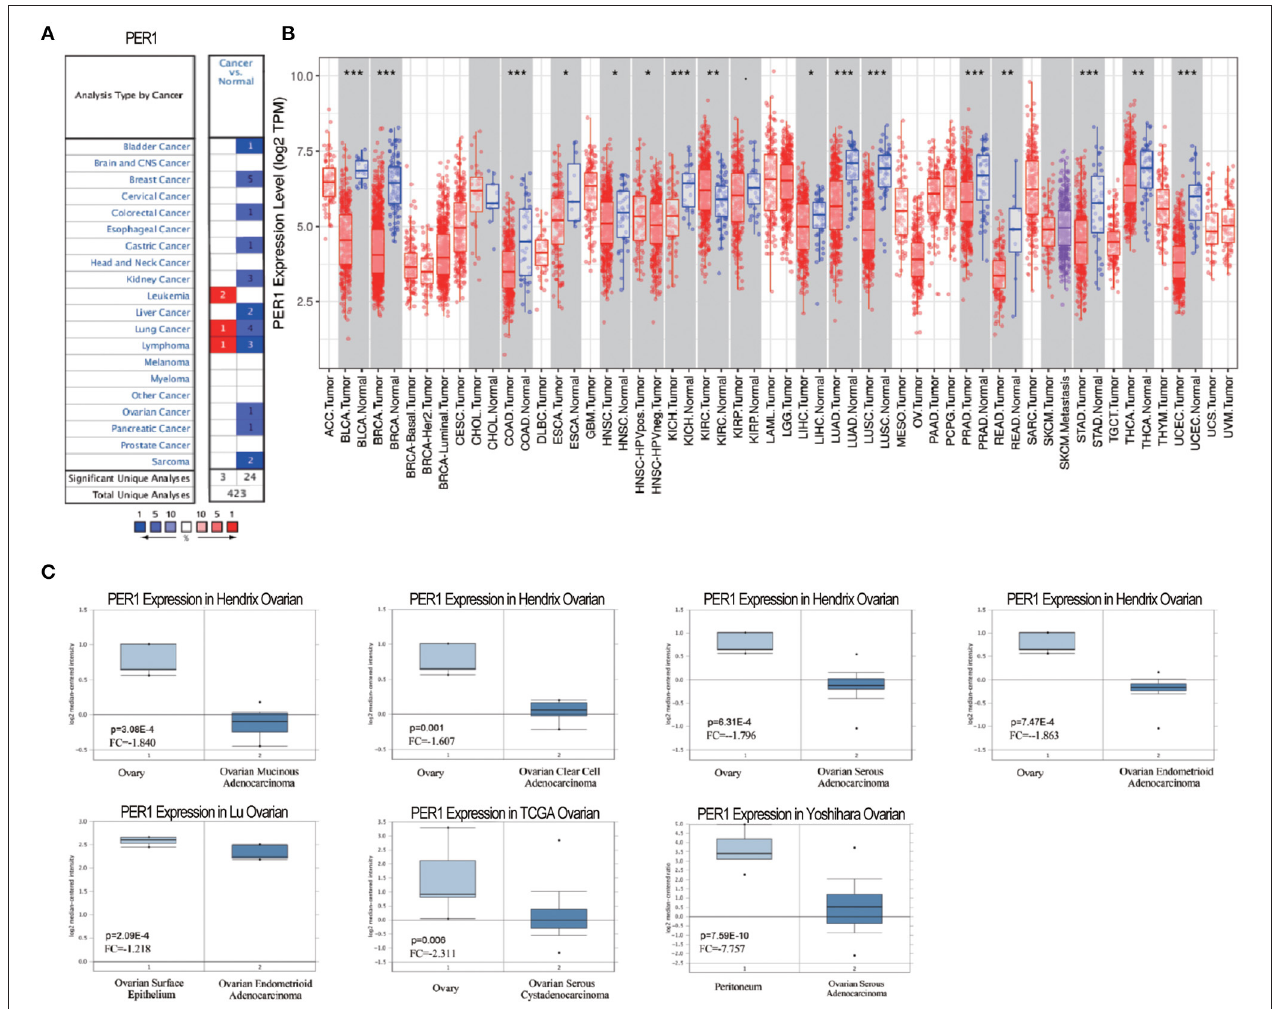
FIGURE 1 | Transcription levels of PER1 in different human cancers. (A) Increased or decreased expression of PER1 in various cancer tissues compared with normal tissues from the Oncomine database. (B) PER1 expression levels in various types of cancer from the TIMER database. (C) Expression of PER1 is downregulated in different types of OV. Box plots comparing PER1 expression in OV patients and normal individuals constructed based on data from the Oncomine